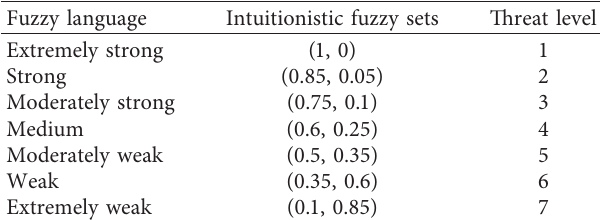
Table 1: Relationship between the fuzzy language and fuzzy